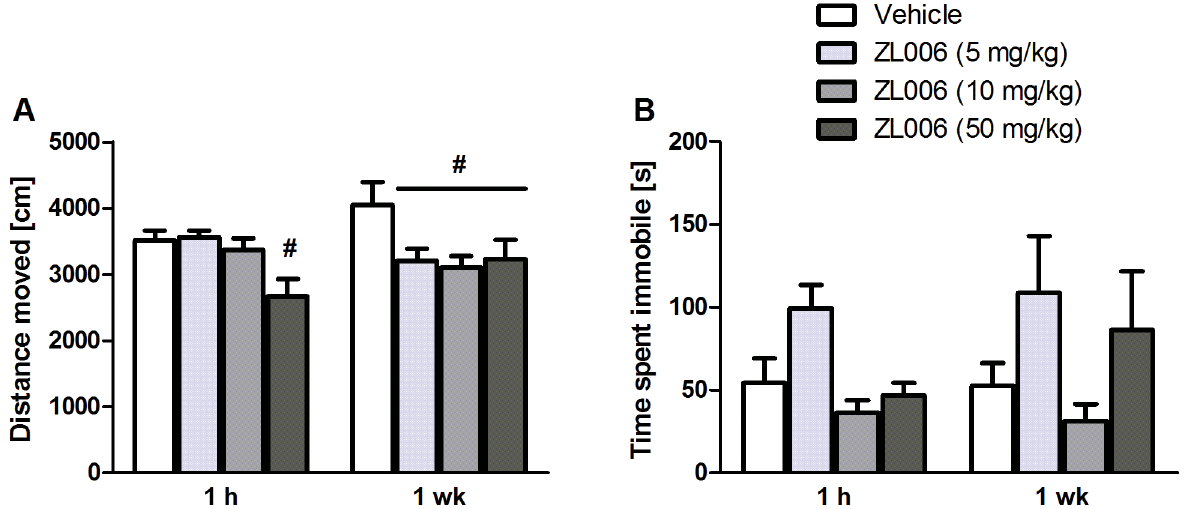
Fig 1. Dose-dependent systemiceffectsin Sprague Dawley rats 1 h and 1 week after injection of vehicle or ZL006 (5, 10, 50 mg/ kg). A : Locomotionduringa 5-min Open Field session. After 1 h, animalsreceiving50 mg/kg ZL006 moved significantly less compared with those treated with vehicle. After 1 week, this effect was present in all ZL006-injected rats; #: p (cid:20) .05 comparedwith respective vehicle; n = 6–8/group. B : Immobility duringa 5-min Forced Swim Test session. There were no significantstrain or treatment effects, p ’s > .05; n = 6–8/group.Valuesare expressedas means ± SEM and were analyzedusing one-wayANOVAs followedby Bonferroni post-hoc